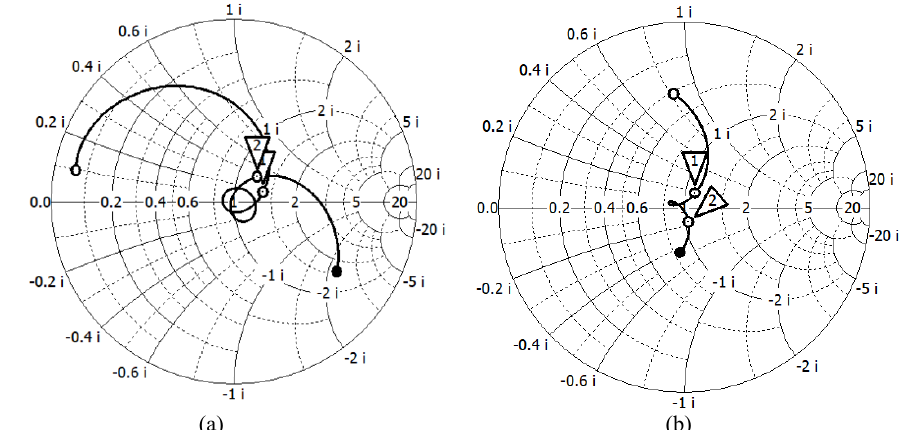
Fig. 5. The Smith Chart of the described dual-polarization antennas, (a) crossed dipole 1695-2695 MHz, (b) square dipole 690-960 MHz. Table.1. Beam width values of the presented